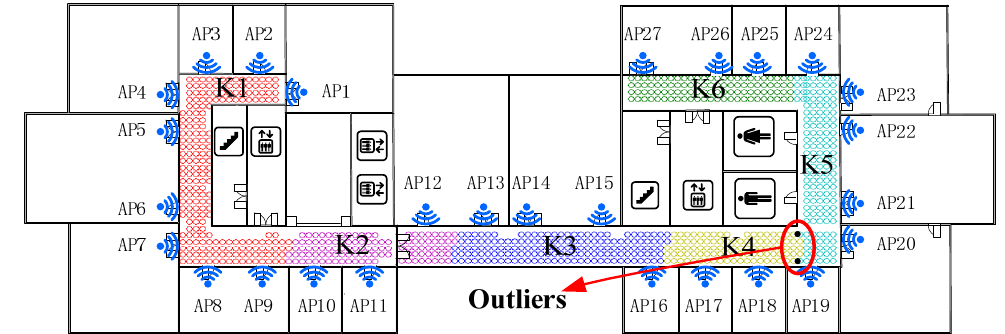
Figure 6. Positioning area clustered by the K-Means